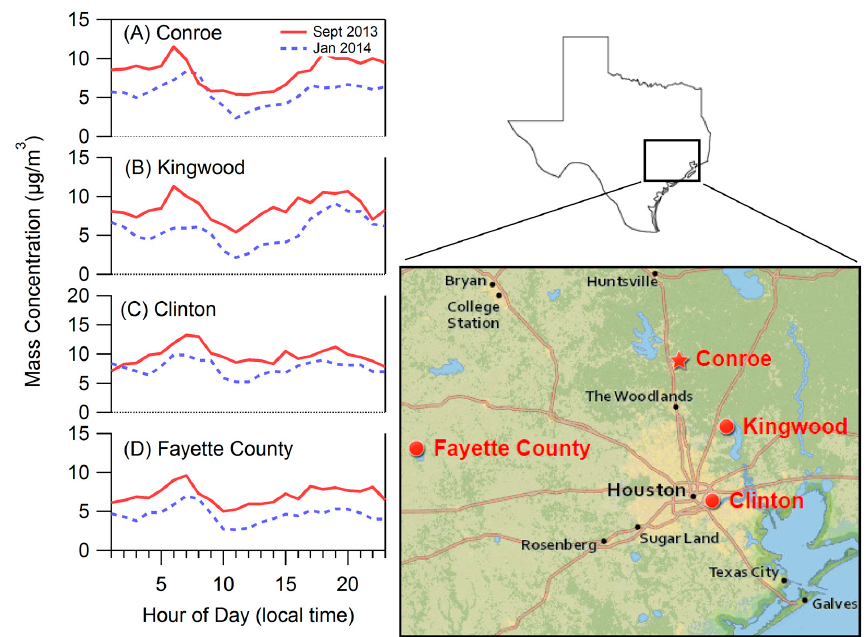
Figure 9. Diurnal plots for Conroe and neighboring areas based on tapered element oscillating microbalance (TEOM) measurements of PM 2.5 by the Texas Commission on Environmental Quality (TCEQ). ( A ) Conroe, ( B ) Kingwood, ( C ) Clinton, ( D ) Fayette County.